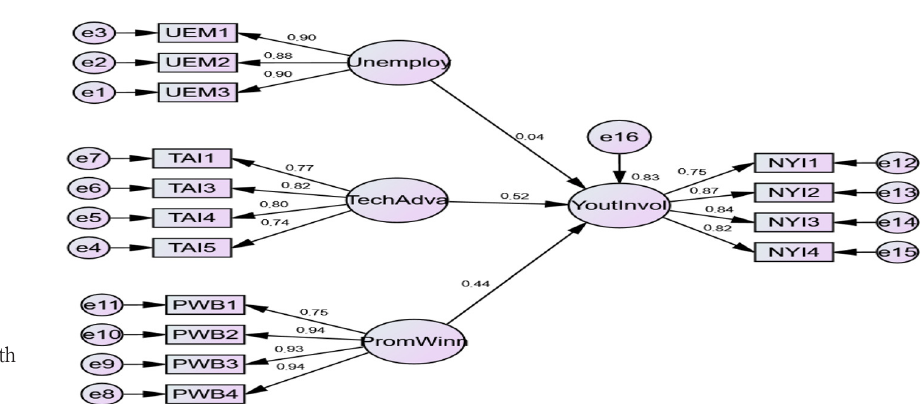
Figure 2. Standardized path model